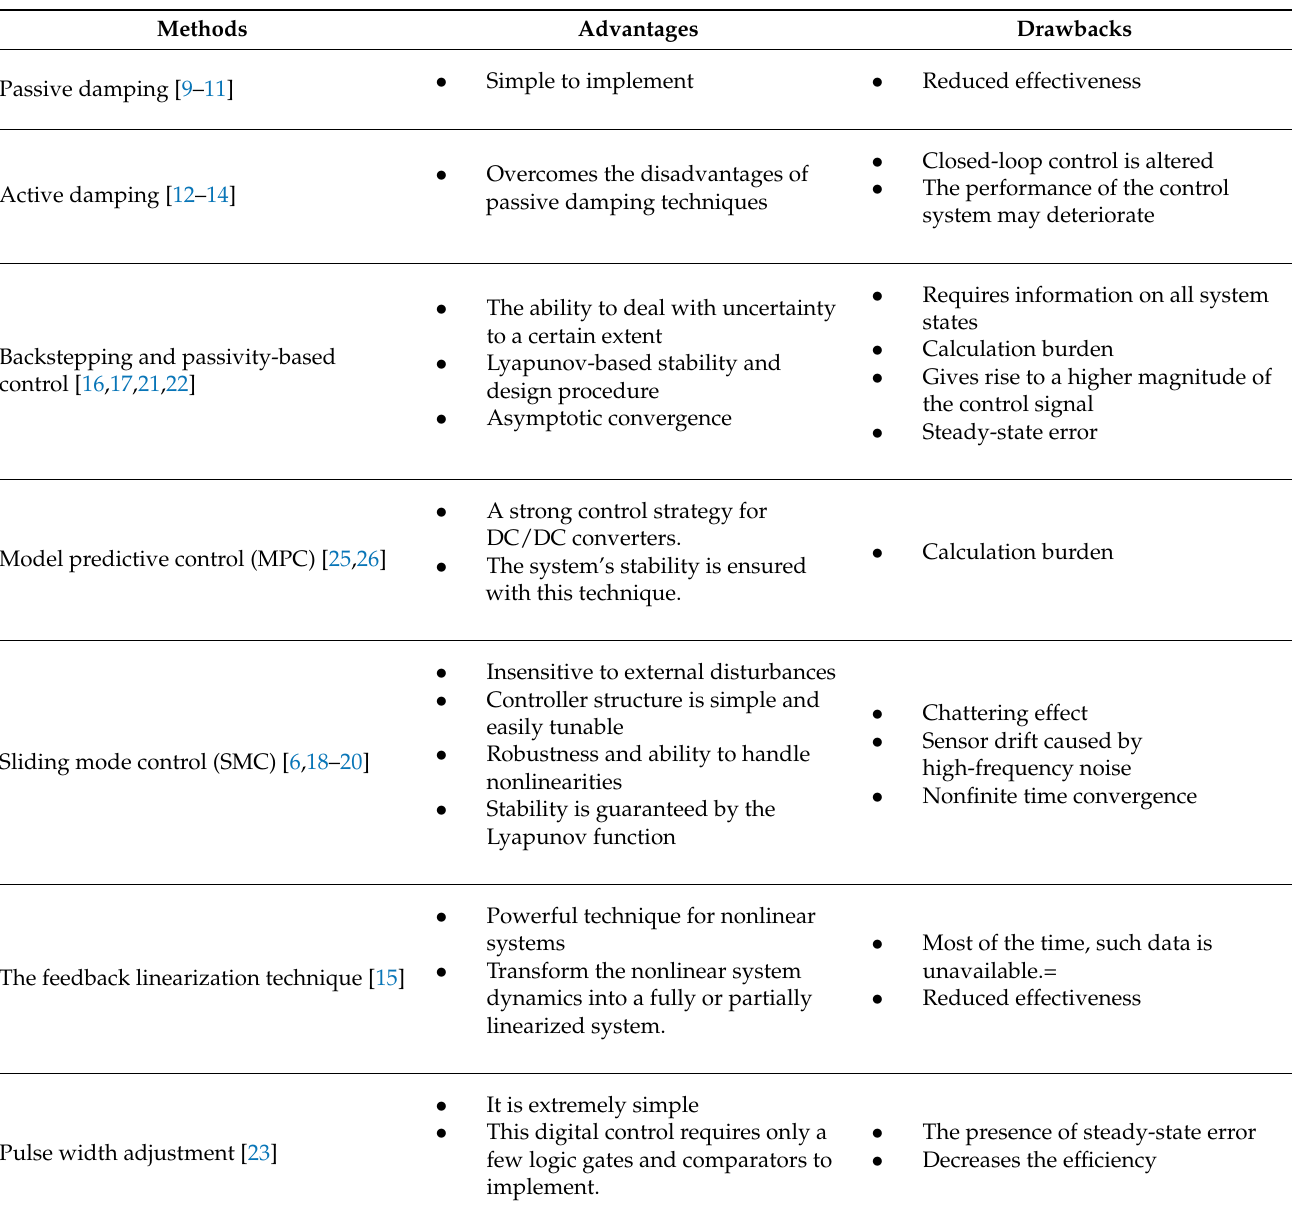
Table 1. Control methods